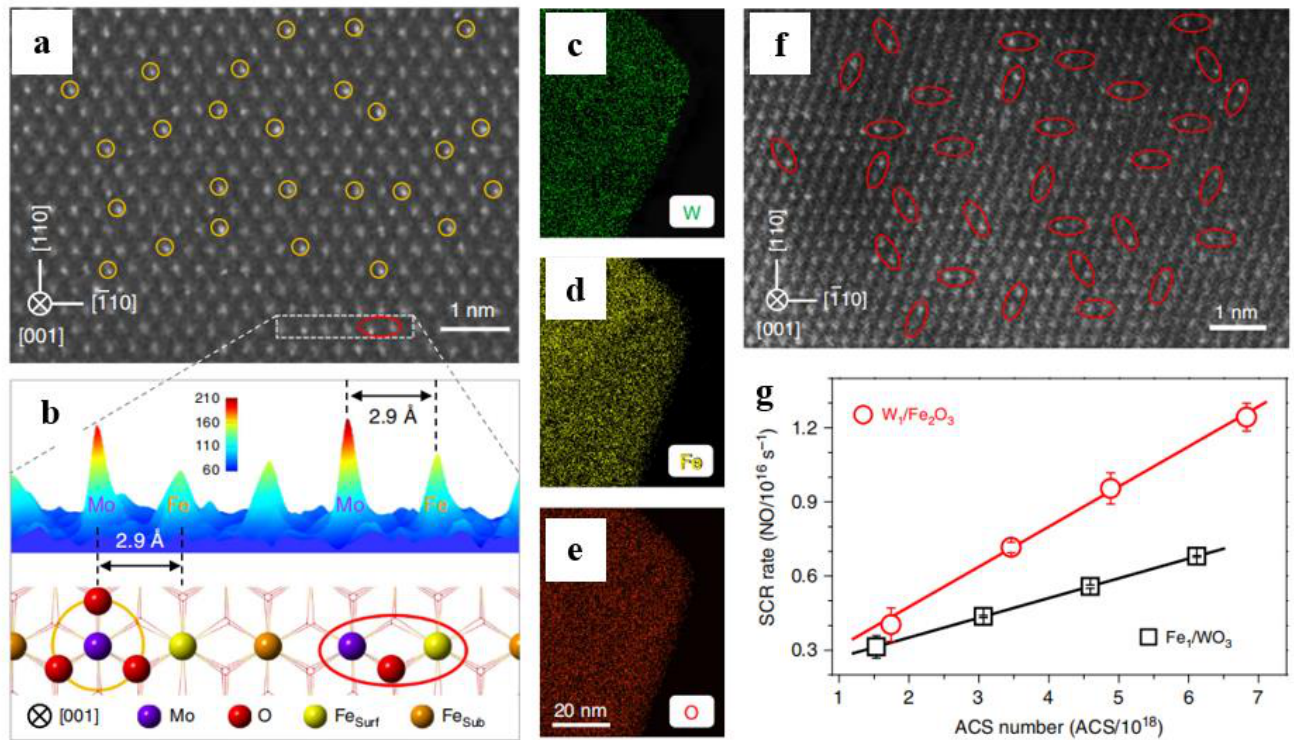
Figure 4. ( a ) AC-STEM image of Mo 1 /Fe 2 O 3 , ( b ) intensity surface plot and the corresponding structural model of the selected area, ( c – e ) EDX mappings and ( f ) AC-STEM image of W 1 /Fe 2 O 3 , ( g ) SCR rates of W 1 /Fe 2 O 3 and Fe 1 /WO 3 with different ACS numbers at 270 °C [96].